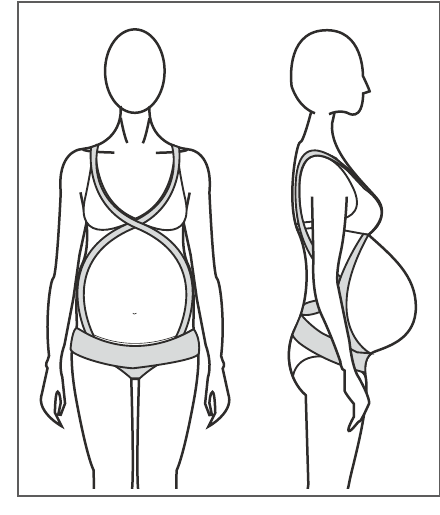
Figure 10: Cradle.